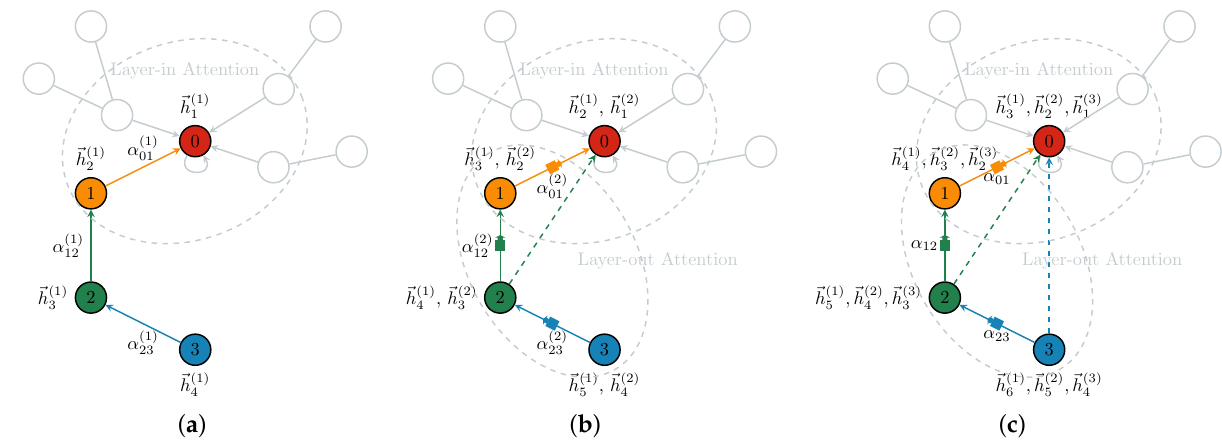
Figure 1. The GGAT Architecture (Shown in Single Head Attention). ( a – c ) are ordered according to the layer number, i.e., ( a – c ) demostrate the information holding status within the first, second and third layer of the Gated Graph ATtention network (GGAT) model, respectively. The labels nearing the coloured nodes indicate the sources of their accumulated information in the current step. For instance, by the end of the second layer’s accumulation process ( b ), the green node possesses information from (cid:126) h ( 1 ) and (cid:126) h ( 2 ) which was gathered from the blue node in the second (current) layer. Likewise, as 3 4 is shown in ( c ), the red node owns information from (cid:126) h ( 1 ) , (cid:126) h ( 2 ) and (cid:126) h ( 3 ) which was gathered from the orange node in the 3 2 1 third layer.